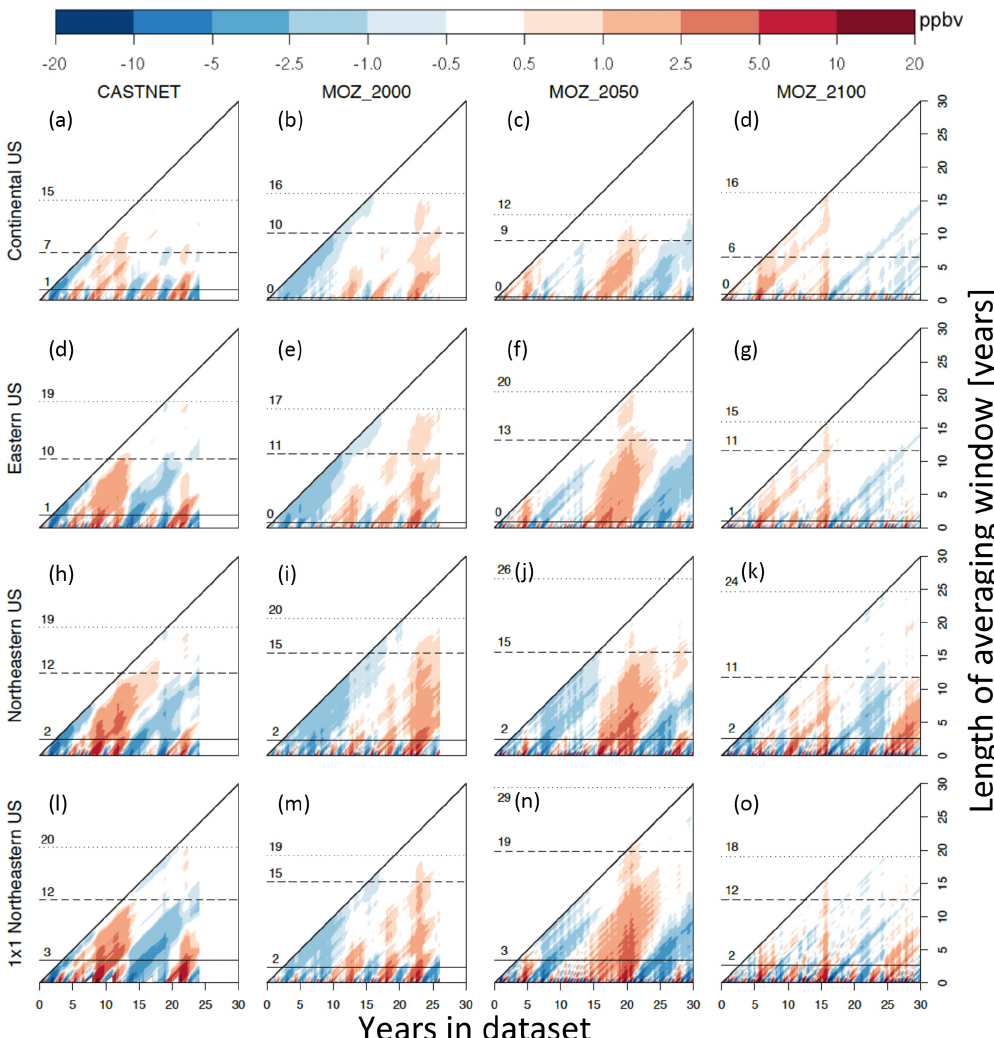
Figure 4. Comparisons of the variability represented by the summertime MDA8 O 3 anomaly (from the long-term summertime mean) for the four datasets in this study (CASTNET, MOZ_2000, MOZ_2050, MOZ_2100, shown in columns) averaged over the four telescoping regions (the continental US, the eastern US, the northeastern US, and a single grid cell within the northeastern US). In each panel, the horizontal axis is the number of years in the dataset (24 years, 1991–2014, for CASTNET; 26 years, 1990–2015, for MOZ_2000; and 30 years, 2036– 2065 and 2086–2115, for MOZ_2050 and MOZ_2100), and the vertical axis represents the length of the averaging window (ranging from 1 day, bottom row, up to the entire time series, top pixel, upper right corner of each triangle). Each pixel represents the estimate of the ozone anomaly for a given averaging window (vertical axis) ending at a given time (horizontal axis). Horizontal lines indicate the length of averaging window required to guarantee that the variability drops below thresholds of 5ppbv (solid), 1ppbv (dashed), and 0.5ppbv